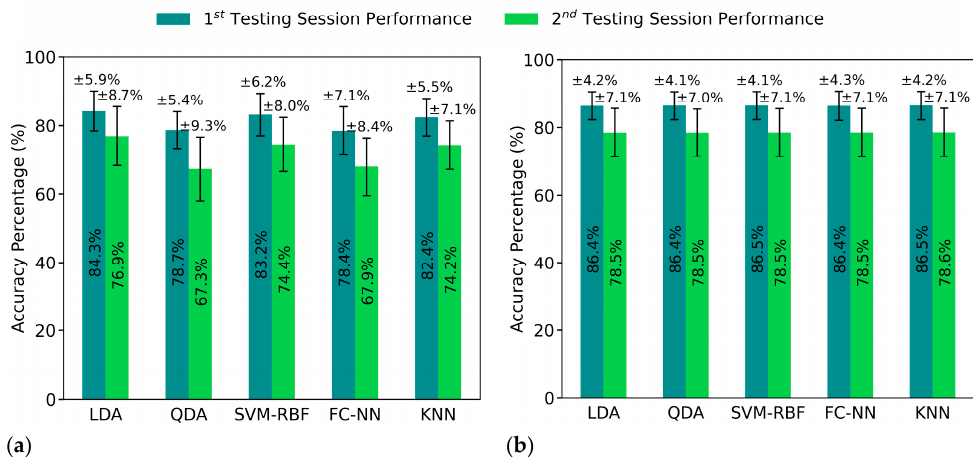
Figure 5. Classifiers’ mean accuracy over all participants for each test session using raw and pipeline features. The error bars are for one standard deviation. ( a ) Mean accuracy using the raw features as